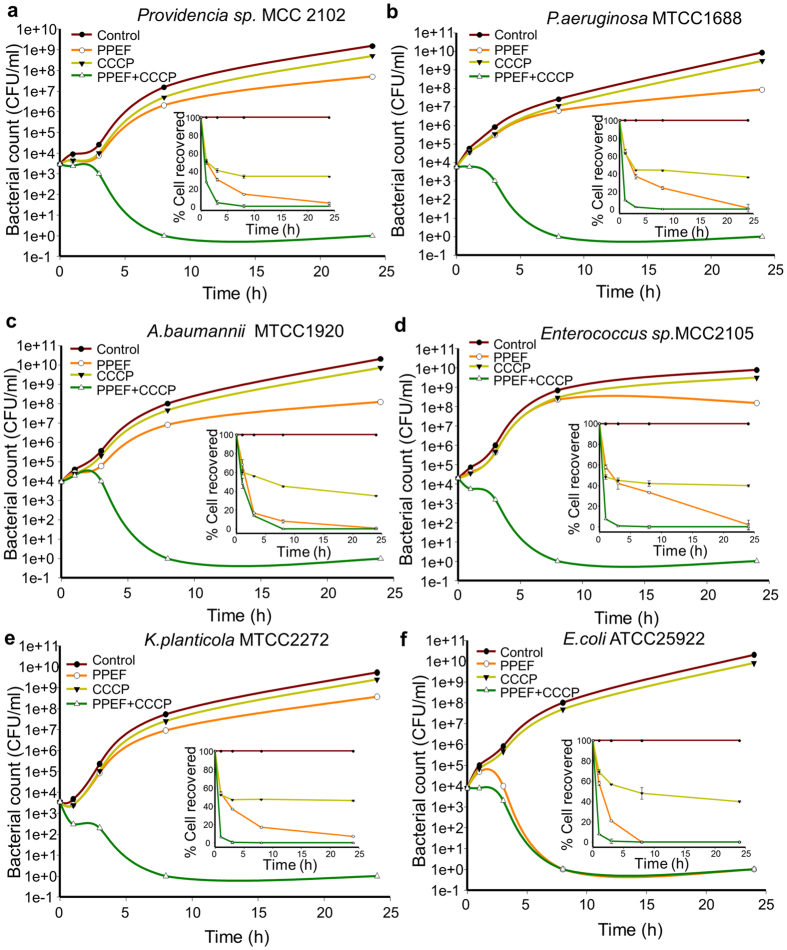
Combination of PPEF and CCCP kills the persistent population.Time-kill curves for bacteria with inset percentage (%) CFU recovered following treatment with 1XMIC PPEF, ½XMIC CCCP and 1XMIC PPEF + ½XMIC CCCP in combination. At the specific time intervals of post treatment viable cells were enumerated using plate count method. (a) Providencia sp. MCC2102 (b) Pseudomonas aeruginosa MTCC1688 (c) Acinetobacter baumannii MTCC1920 (d) Enterococcus sp. MTCC2105 (e) Klebsiella planticola MTCC2272 (f) E. coli ATCC25922. Inset graph shows results of % CFU recovered represent mean (±SD) of three independent experiments (n = 3).